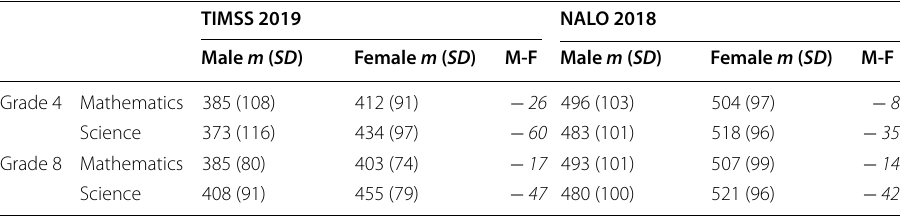
Table 2 Mean mathematics and science achievement in Saudi Arabia, by grade level and gender, TIMSS 2019 and NALO